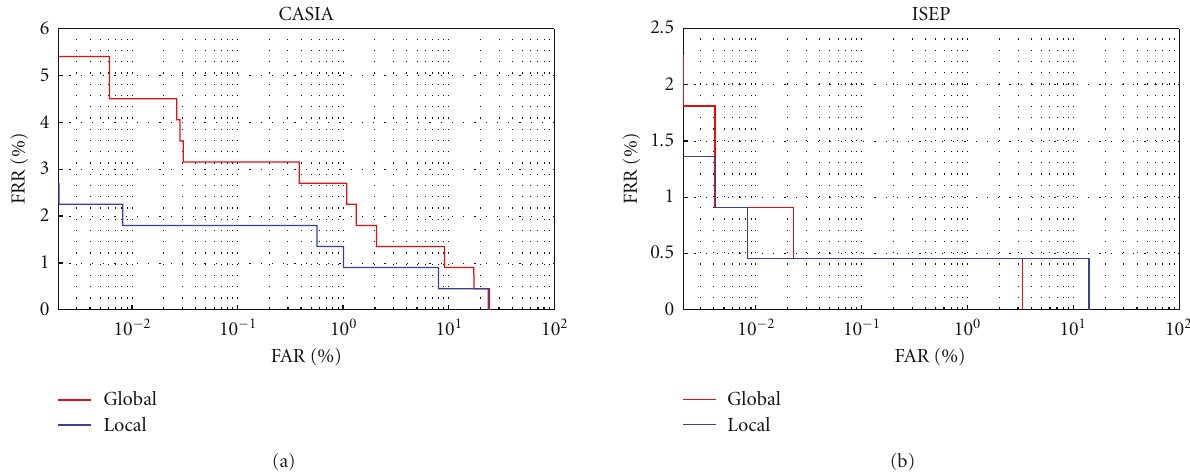
Figure 21: ROC curves obtained with automatically segmented databases, for both global and local comparison methods, on (a) CASIA and (b) ISEP